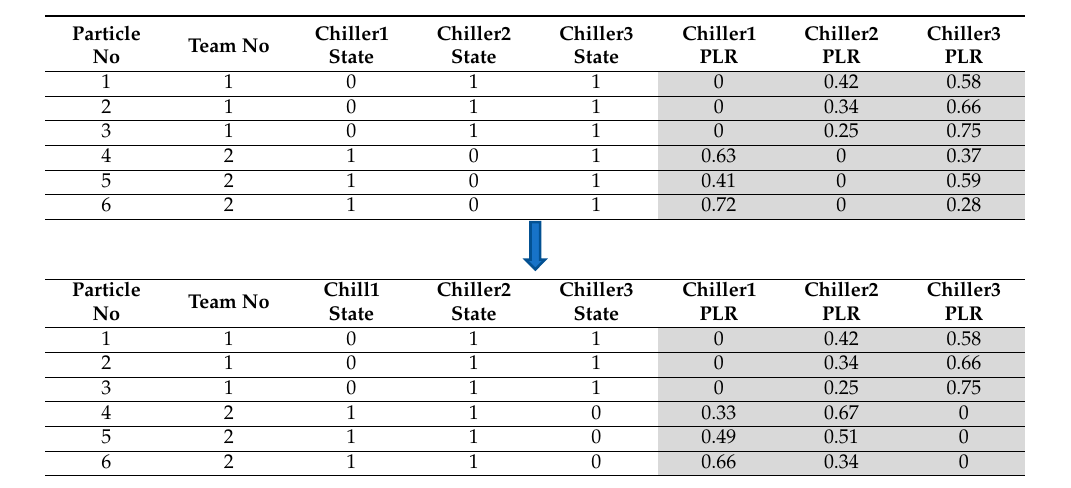
Table 5. Step 5: the team evolution for on-off states of chillers.